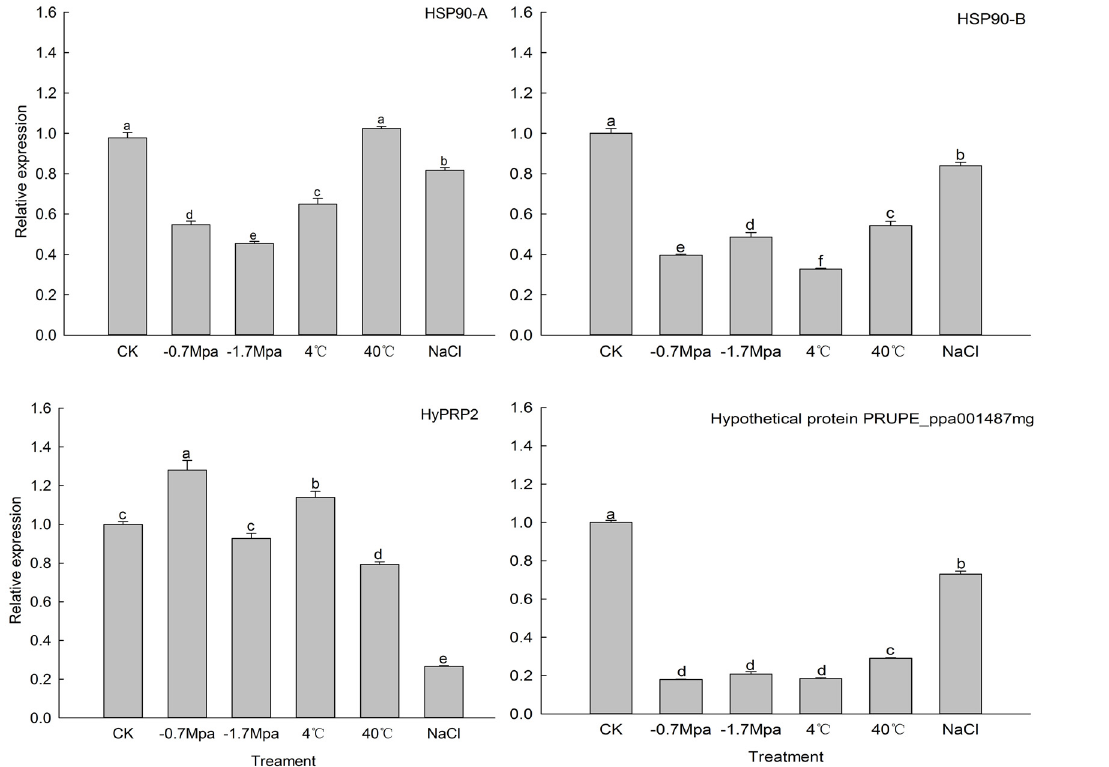
Fig 9. qRT-PCR analysis of stress-response